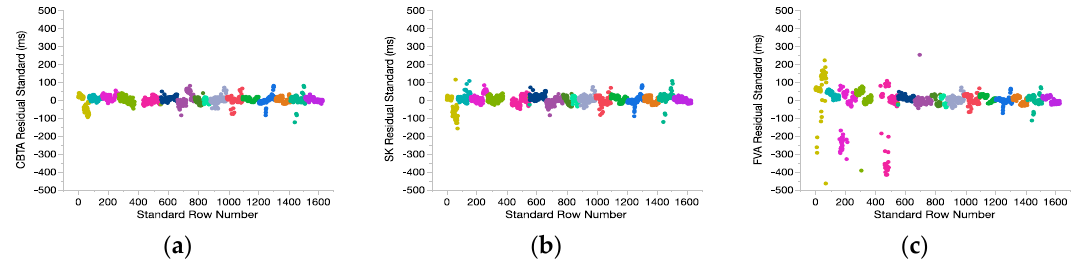
Figure 3. Gait event time residuals (ms) when detected with different kinematic methods for